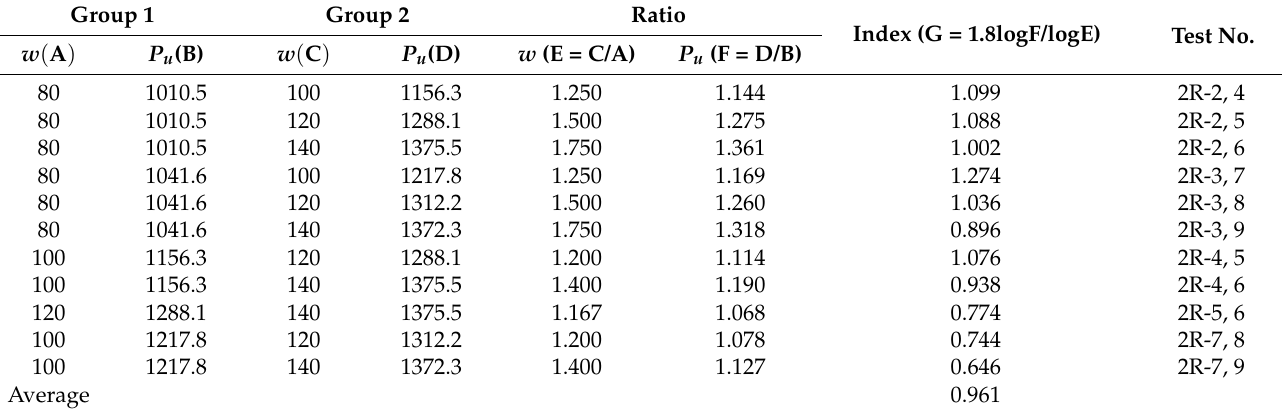
Table 12. Index value for the variable of w .